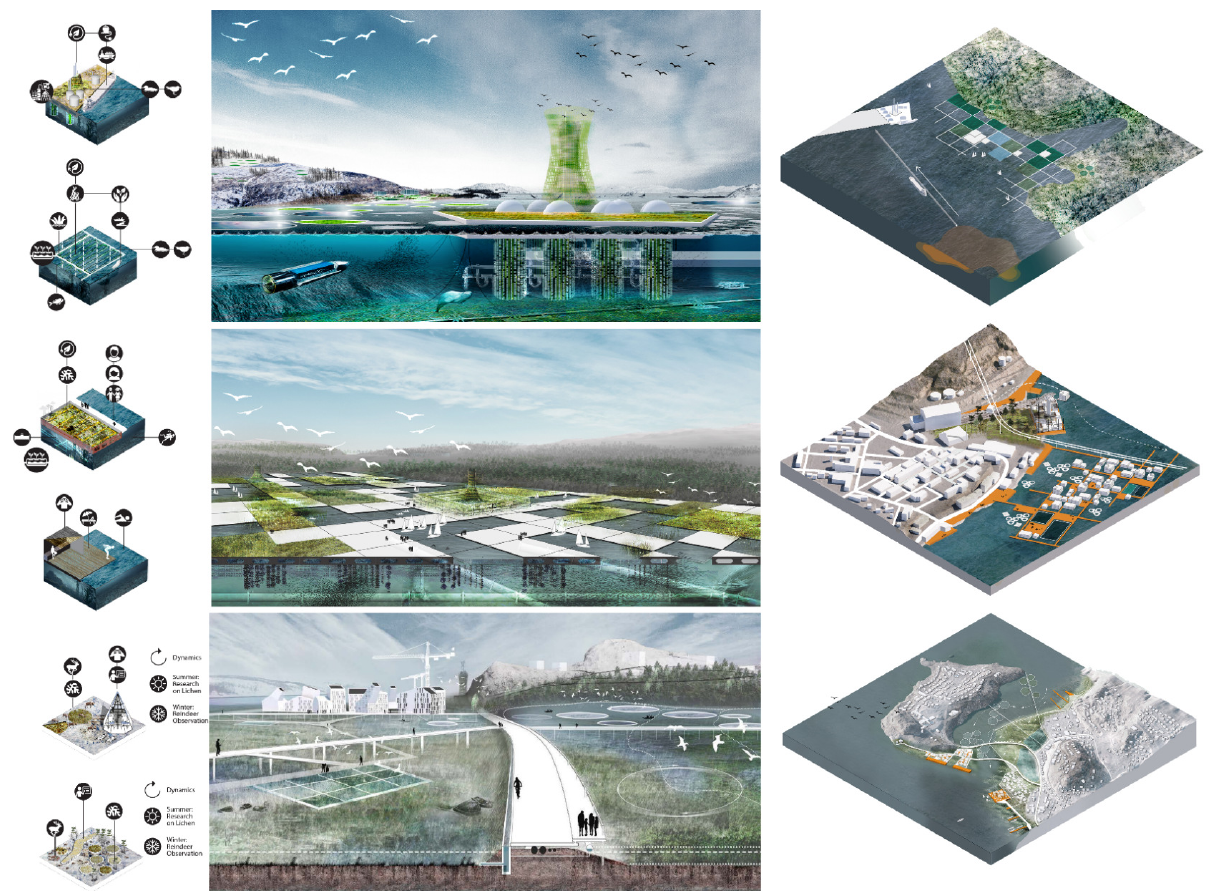
Figure 6. Visualizations of the three “ParadoxSynergy Scapes”: Reindeer‐Energy Port, Urban Port, and Wetland Port. Source: Höller